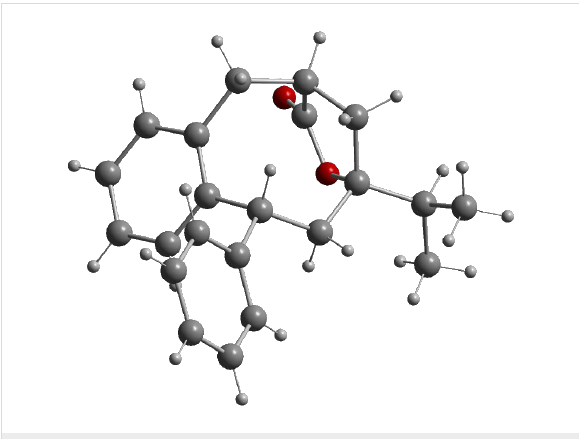
Figure 3: Molecular structure (Diamond [52]) of compound 17b .